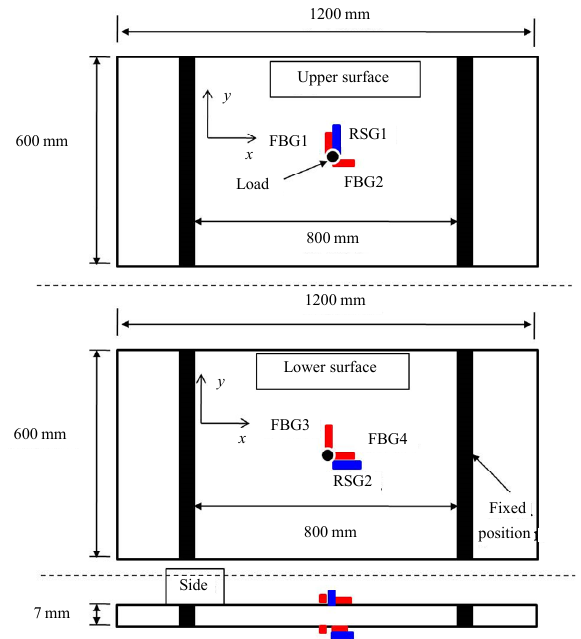
Fig. 2 Picture of experimental setup: (a) concentrated static load and (b) impact load. Fig. 3 Sensor layout on the glass